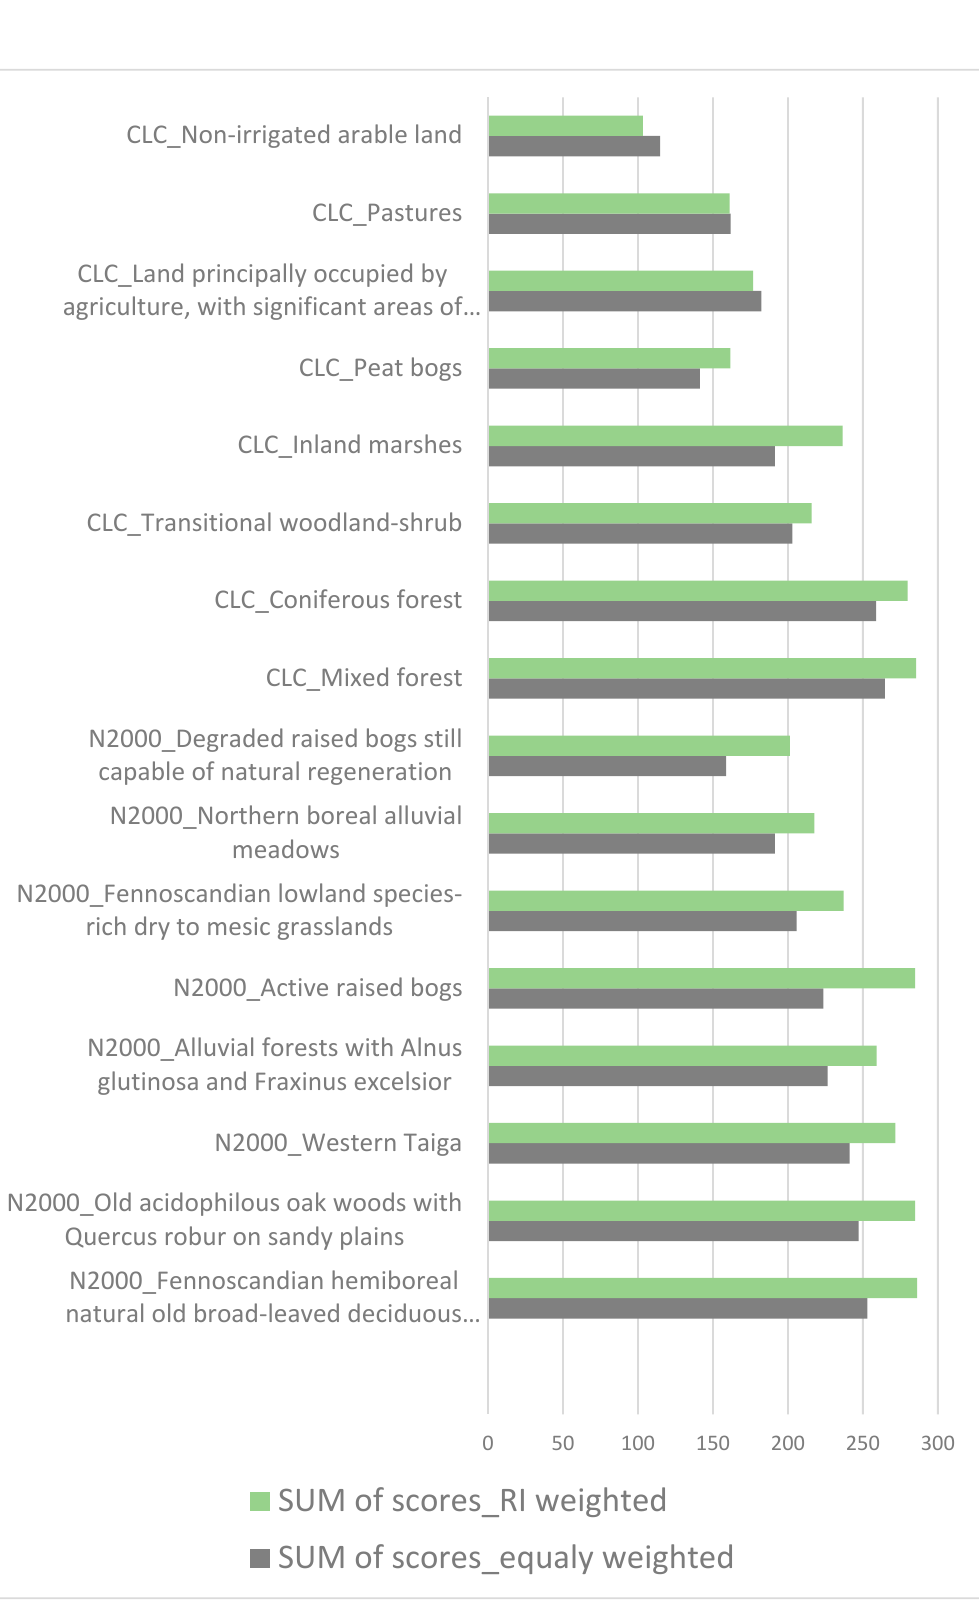
Figure A1. Ranking of land-cover classes using overall Ecosystem Services potential values sum of equally (×100/34) weighted values and RI (provided in Table 2) weighted values.